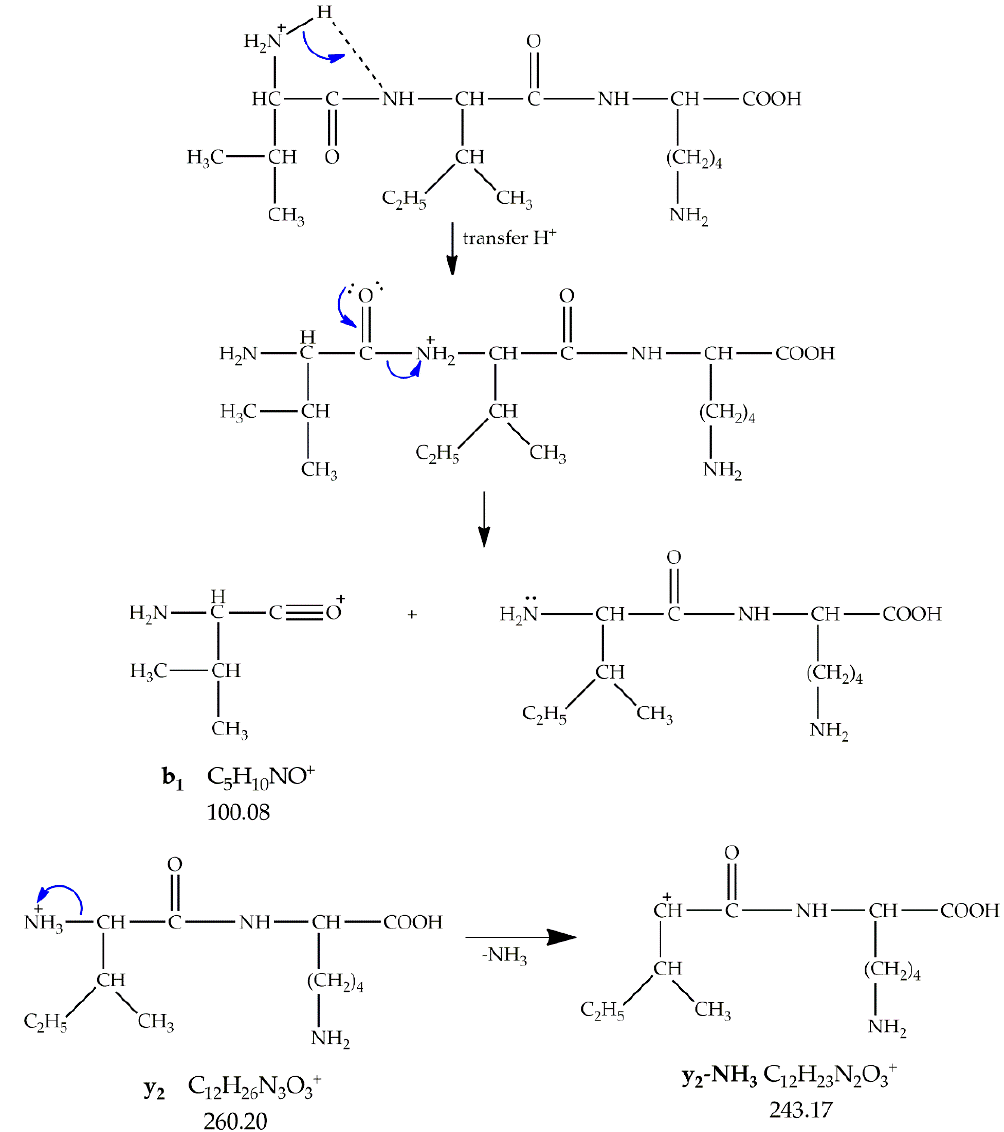
Table 5. Additional types of fragments identified for Val-Ile-Lys